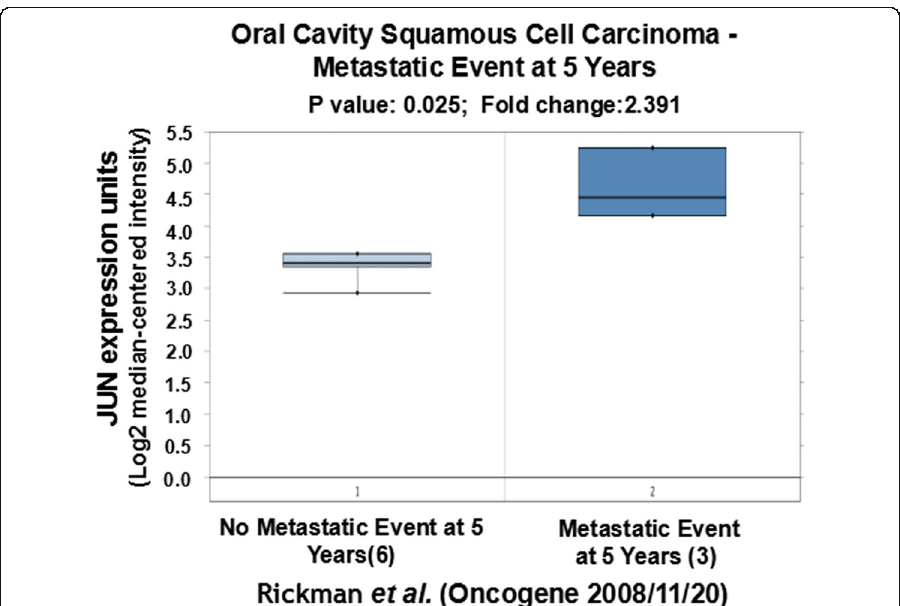
Fig. 5 Comparison of JUN expression in oral cavity squamous cell carcinoma without metastatic events at 5 years and with metastatic events at 5 years